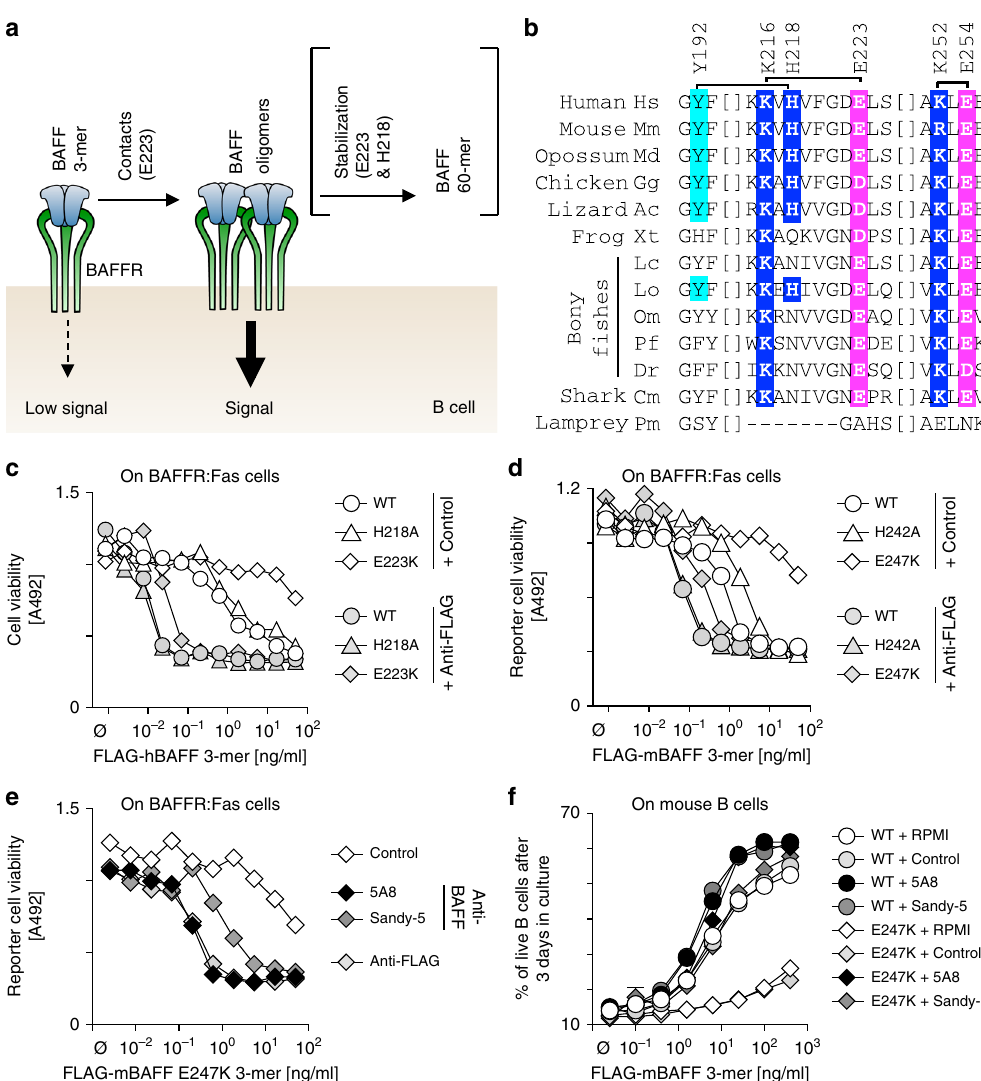
Fig. 4 Increase and rescue of BAFF activity by cross-linking. a Model of the role of the fl ap of BAFF for activation of BAFFR signaling: fl ap – fl ap interactions for which residue E223 is important mediate interactions between receptor-bound BAFF 3-mers. This promotes BAFFR signaling. Flap – fl ap interactions for which residues E223 and H218 are both required can further lead to assembly of BAFF 60-mer. b Sequence alignment of BAFF from different vertebrates in regions relevant for 3-mer to 3-mer interactions. Residue numbering is for human BAFF. Brackets link residues with symmetric interactions (e.g., K216 of one BAFF 3-mer interacts with E223 of another BAFF 3-mer and vice-versa, see also Fig. 1a), where acidic residues are shown in magenta, basic residues in blue, and the tyrosine that pairs with His218 in turquoise. Hs: Homo sapiens ; Mm: Mus musculus ; Md: Monodelphis domestica ; Gg: Gallus gallus ; Ac: Anolis carolinensis ; Xt: Xenopus tropicalis ; Lc: Latimeria chalumnae ; Lo: Lepisosteus oculatus ; Om: Oncorhynchus mykiss ; Pf: Poecilia formosa ; Dr: Danio rerio ; Cm: Callorhinchus milii ; Pm: Petromyzon marinus . c Cell viability measured in BAFFR:Fas reporter cells exposed to the indicated concentrations of FLAG-hBAFF WT or mutants in the presence of a fi xed concentration of a control antibody (EctoD1) or of an anti-FLAG cross-linking antibody. The experiment was performed twice. d Same as panel c , but for FLAG-mBAFF. The experiment was performed twice. e Same as panel d , but for FLAG-mBAFF E247K in the presence of a constant concentration of a control antibody (EctoD1), of a cross-linking antibody (anti-FLAG), or of cross-linking anti-mBAFF monoclonal antibodies (5A8 and Sandy-5). The experiment was performed twice. f Cell viability of primary splenic mouse B cells cultured for 3 days in the presence of titrated amounts of FLAG-mBAFF WT or E247K, alone or in the presence of fi xed amounts of control (EctoD1) or cross-linking (5A8, Sandy-5) antibodies. Each point is the mean ± SEM of technical triplicates. Experiment performed once in this format (and once with less titration